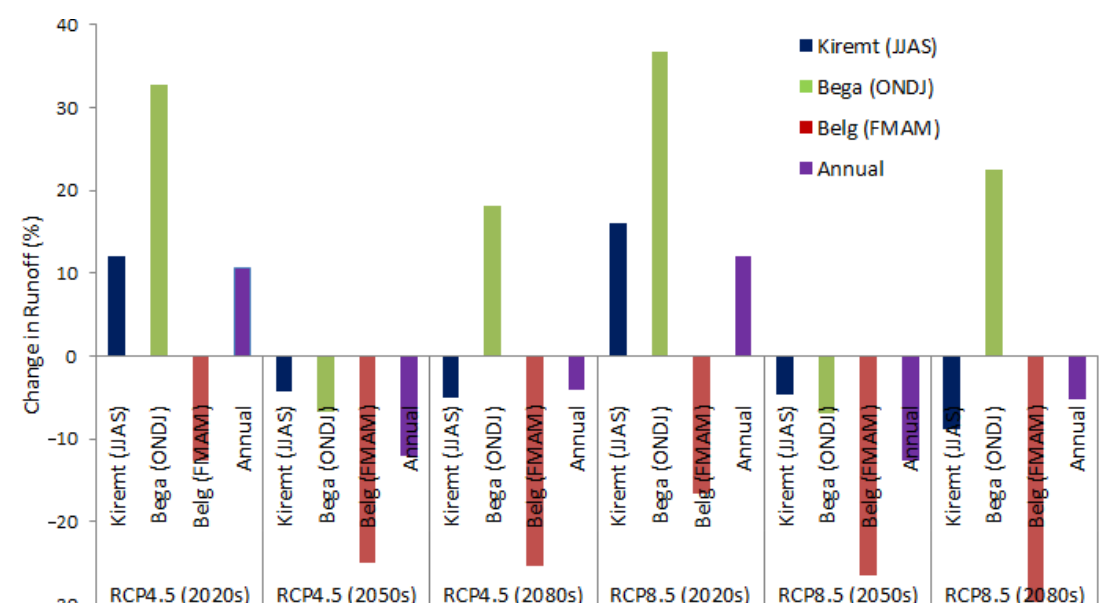
Figure 12. Seasonal and annual change in runoff for three time periods under RCP4.5 and RCP8.5.